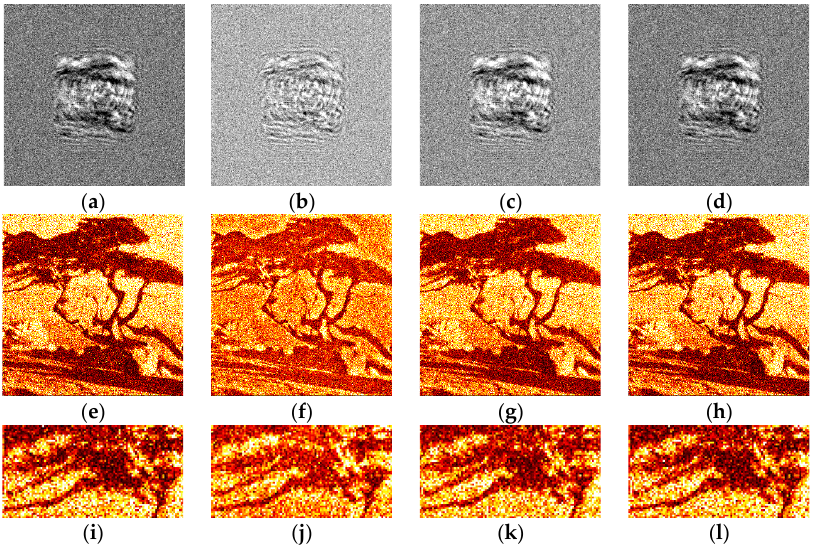
Figure 4. Examples of synthesized binary inline Fresnel holograms containing the “Tree” image, corresponding reconstructed images and their enlarged fragments. Holograms were binarized using the Otsu ( a , e , i ), Sauvola ( b , f , j ), Li ( c , g , k ), and Huang ( d , h , l ) methods.